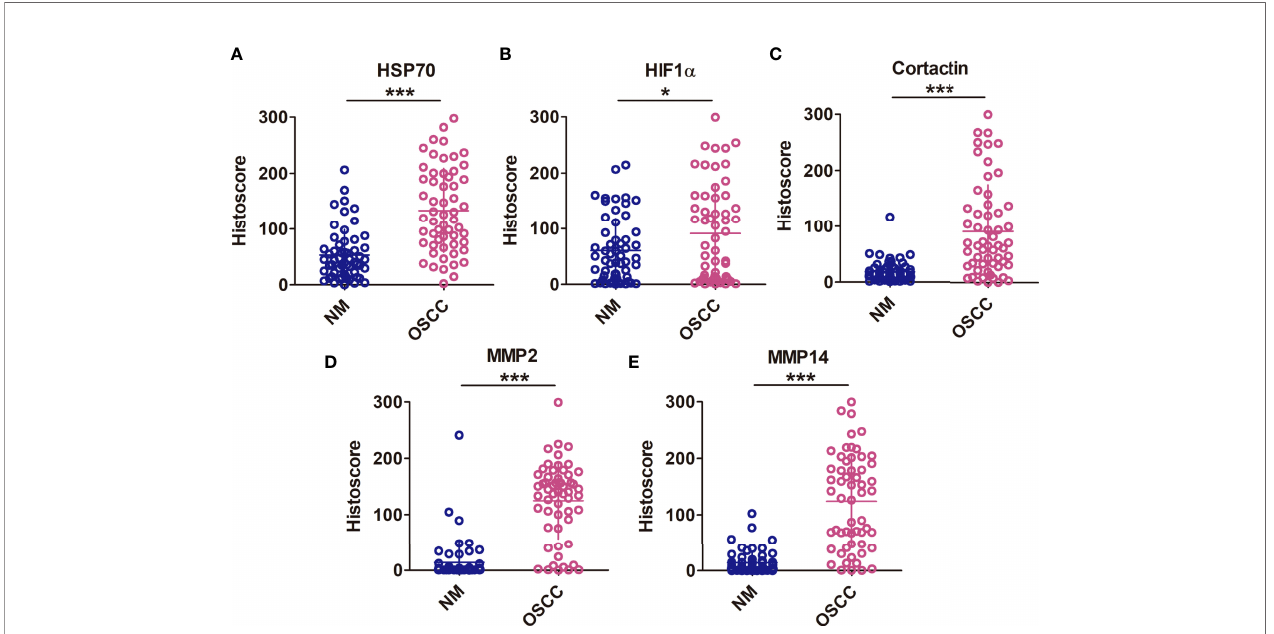
FIGURE 2 | High expression of HSP70, Hif1 a , MMP2, MMP14, and cortactin in OSCC . Histoscores of Hsp70 (A) , Hif1 a (B) , cortactin (C) , MMP14 (D) , and MMP2 (E) in both tumor and normal tissues, and observed signi fi cantly higher expression levels of these proteins in OSCC tissues. Means ± SEM. *P < 0.05; ***P < 0.001 versus the NM group; Student ’ s t-test